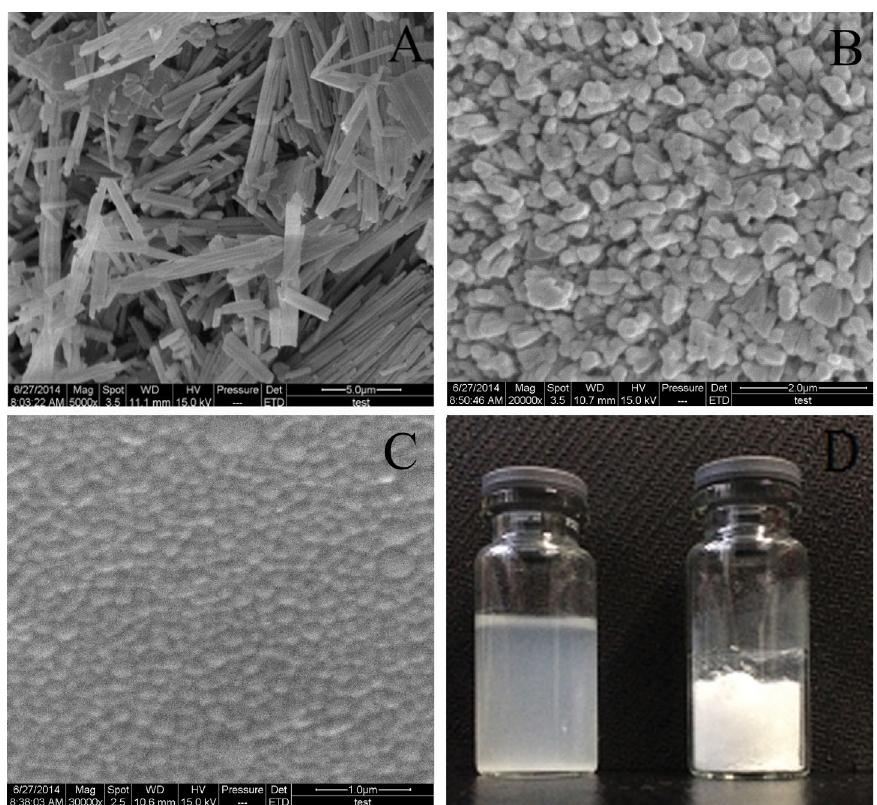
FIGURE 1 - Characterization of DTX, DTX-BSA-NPs and DTX-BIO-BSA-NPs. Scanning electron microscopic images of (A) raw docetaxel (magnification: 5000×). (B) DTX-BSA-NPs (magnification: 20000×). (C) DTX-BIO-BSA-NPs (magnification: 30000×). (D) Reconstitution appearance of DTX-BIO-BSA-NPs solution (left) and freeze-dried DTX-BIO-BSA-NPs powder